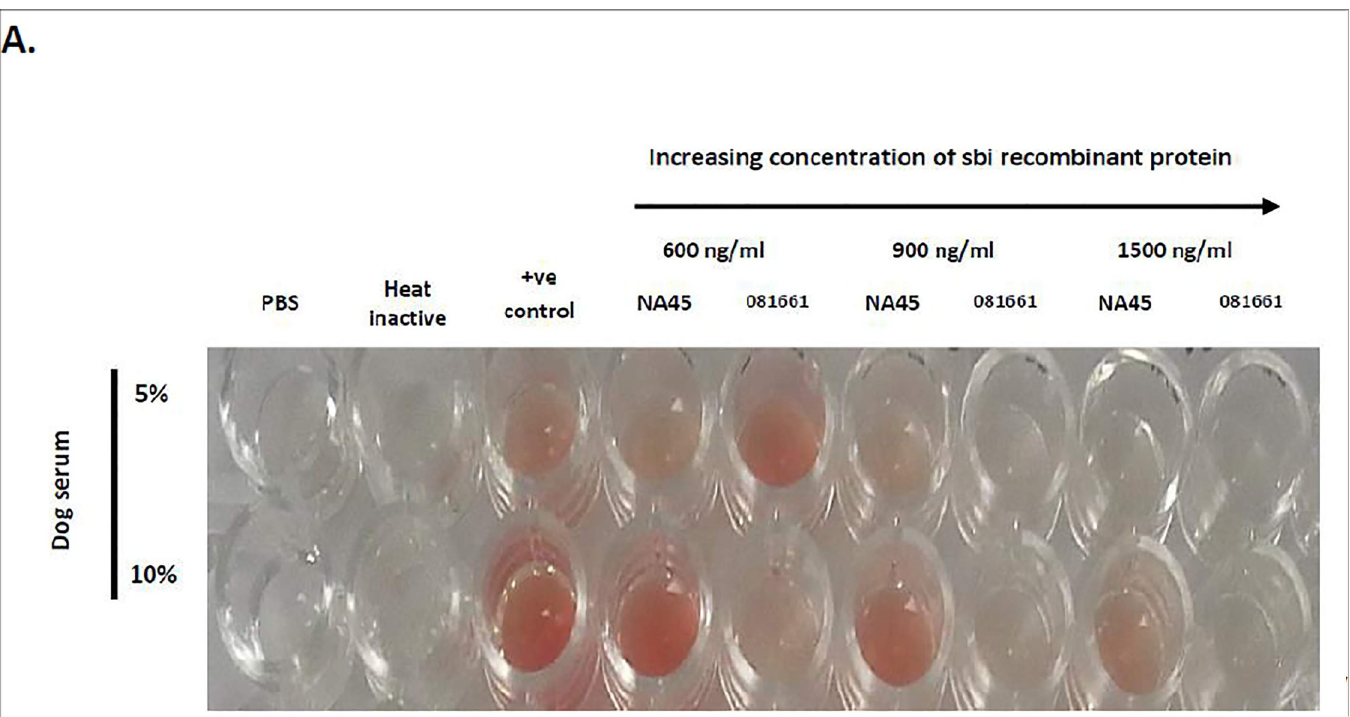
Fig 7. prSbi inhibits complement activity. Hemolysis of sensitized bovine erythrocytes was assayed in the presence of increasing concentrations of prSbi from NA45 and 081661. prSbi from of 081661 was significantly more effective than NA45 prSbi (p < 0.0001). All concentrations of prSbi from NA45 were different from the negative controls � p < 0.05 except at 1500ng/ml whereas none of the concentrations of 081661 prSbi differed from the negative control (Ns).